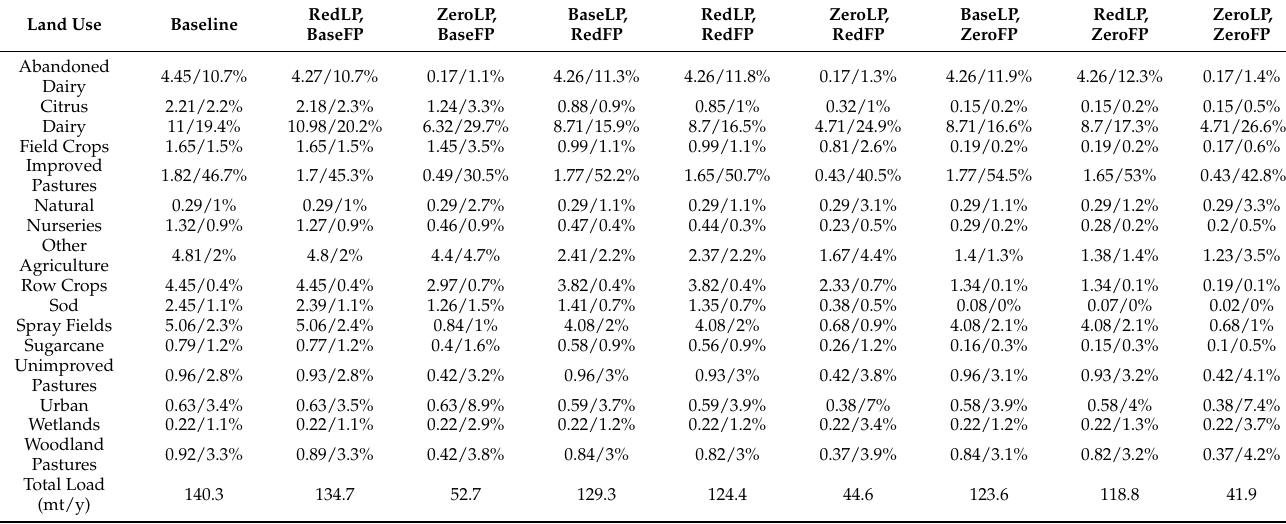
Figure 7. Source-level unit area load maps for the ( a ) Baseline, ( b ) reduced legacy P and Baseline inorganic fertilization (RedLP, BaseFP), ( c ) zero legacy P and Baseline inorganic fertilization (ZeroLP, BaseFP), ( d ) Baseline legacy P and reduced inorganic fertilization (BaseLP, RedFP), ( e ) reduced legacy P and reduced inorganic fertilization (RedLP, RedFP), ( f ) zero legacy P and reduced inorganic fertilization (ZeroLP, RedFP), ( g ) Baseline legacy P and zero inorganic fertilization (BaseLP, ZeroFP), ( h ) reduced legacy P and zero inorganic fertilization (RedLP, ZeroFP), and ( i ) zero legacy P and zero inorganic fertilization (ZeroLP, ZeroFP). Table 4. Land use average unit area total phosphorus load (UATPL) (kg/ha/y) and percent contribution to source-level TP loads in the TCNS.